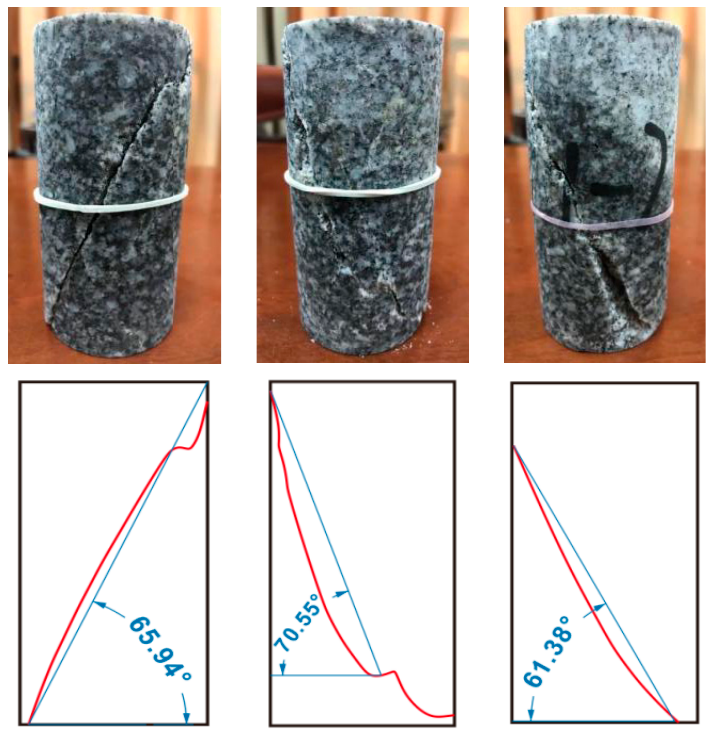
Figure 11. Test results and failure modes of granite with confining pressure at 10 MPa.